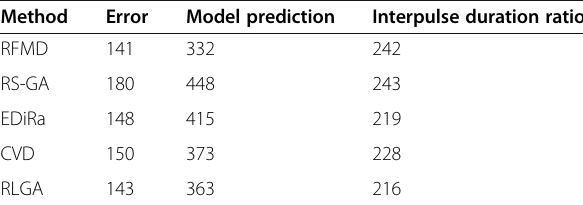
Table 9 Number of discrete intervals in each attribute of the banknote authentication dataset